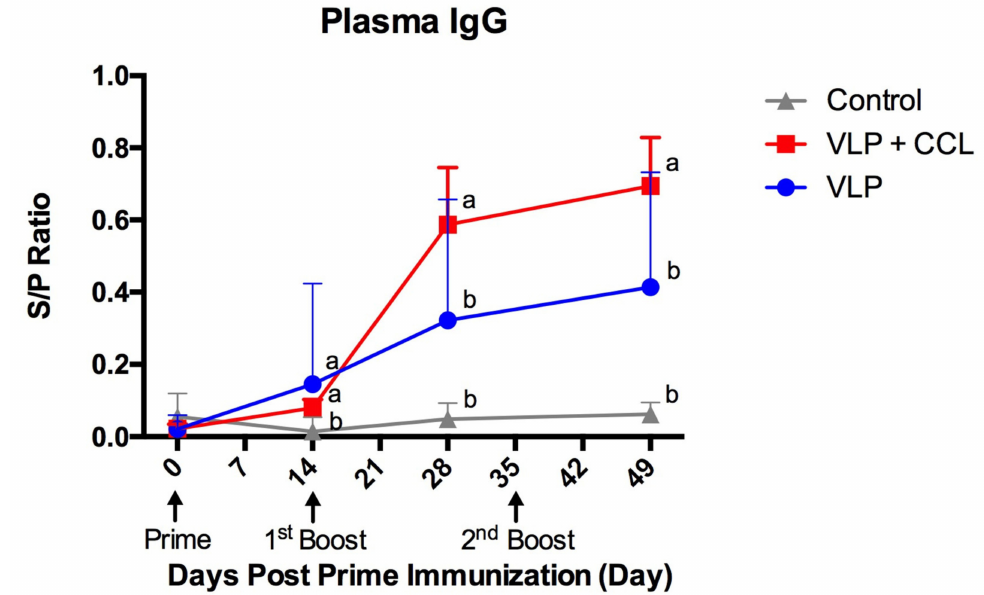
Figure 7. Systemic PEDV S-specific IgG titers following the prime, 1st boost, and 2nd boost. Pigs were immunized with di ff erent regimens at 0, 14, and 35 DPPI. Blood was collected at 0 (pre-priming), 14, 28, and 49 DPPI for evaluating PEDV-specific IgG titer by the PEDV S-based ELISA. The results are shown as averaged values of sample-to-positive ratios (S / P ratio) with error bars representing the SEM. The values in control, VLP, and VLP + CCL groups are demonstrated by gray, blue, and red lines, respectively. Di ff erent alphabets indicate significant di ff erences among di ff erent groups ( p < 0.05). Compared to the control group, the oral IgA S / P titers elicited in the VLP and VLP + CCL groups at 49 DPPI were 0.16 ± 0.05 and 0.15 ± 0.05, respectively (Figure 8). Statistical analysis of oral IgA revealed the main e ff ects of time (Wald chi-square = 21.983, p < 0.001), treatment (Wald chi-square = 11.703, p = 0.020), and BW (Wald chi-square = 5.674, p = 0.017). Significant interactions of treatment × time (Wald chi-square = 297.607, p < 0.001), treatment x BW (Wald chi-square = 19.334, p = 0.001), time × BW (Wald chi-square = 19.783, p = 0.001), and treatment × time × BW (Wald chi-square = 157.940, p < 0.001) were presented. Following the removal of the interaction e ff ects of BW, post hoc comparisons of the simple main e ff ects indicated that the mucosal IgA levels were significantly higher in the VLP + CCL group than in the control group at 49